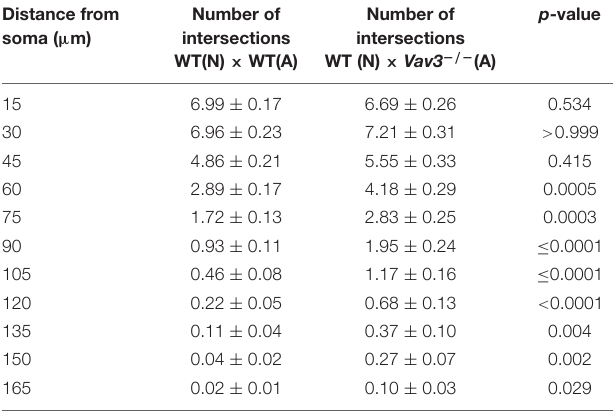
TABLE 3 | Intersection numbers of wildtype neurons cultured with Vav3 − / − astrocytes in comparison to the control condition after cultivation time of 12 days.